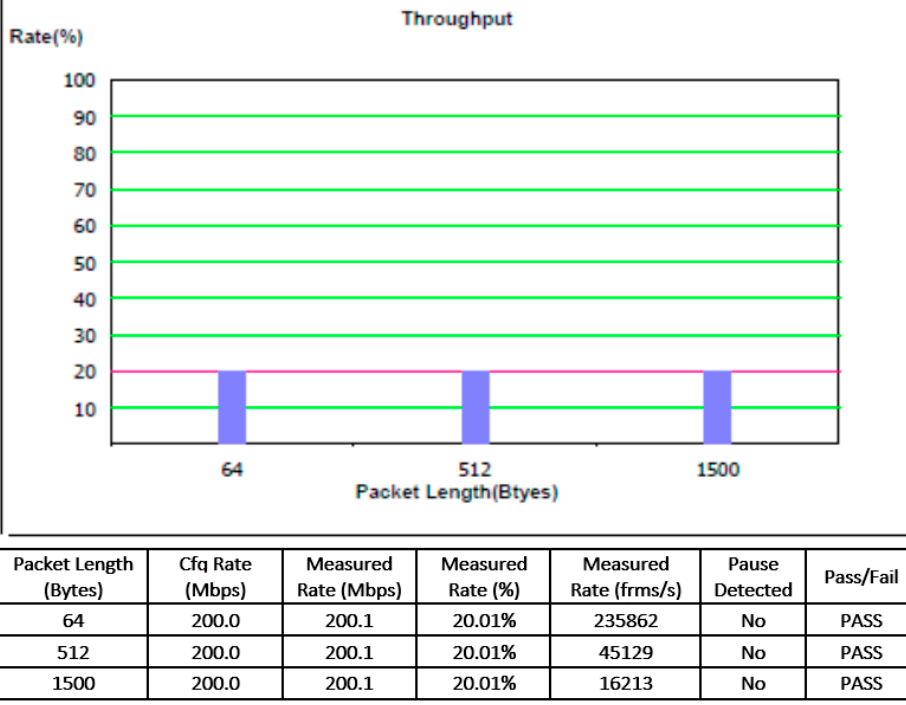
Figure 18. Throughput.